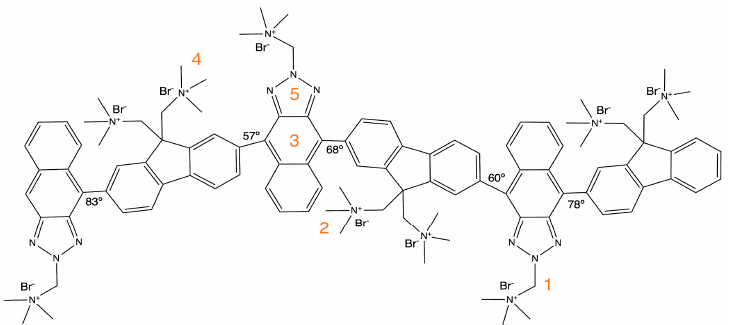
Figure 4. Dihedral angles of the optimized CPE trimer and potential binding sites with CuNPs.